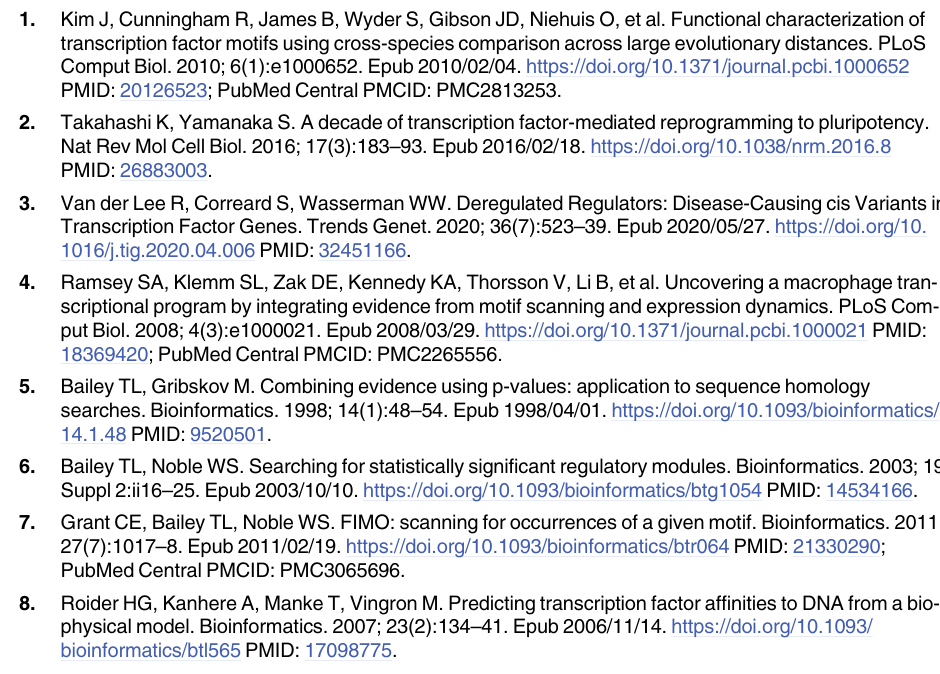
S3 Table. Detailed information of the publicly available Chip-Seq datasets (Altas-2021) with literature